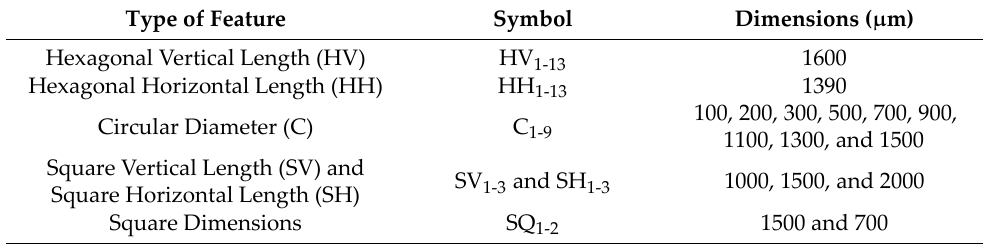
Table 2. Features for bioprinting resolution